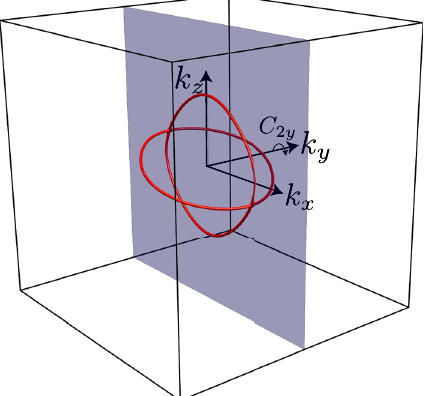
FIG. 16. The nodal lines of the tight-binding model in Eq. (118) for μ ¼ þ 1 . The blue plane is the mirror symmetric